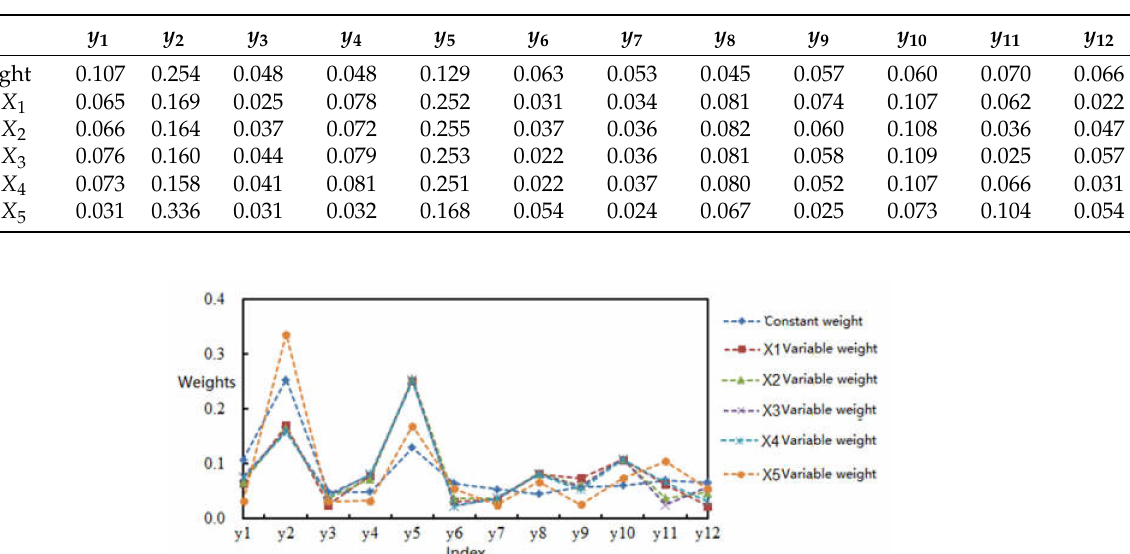
Table 4. Evaluation index weights.